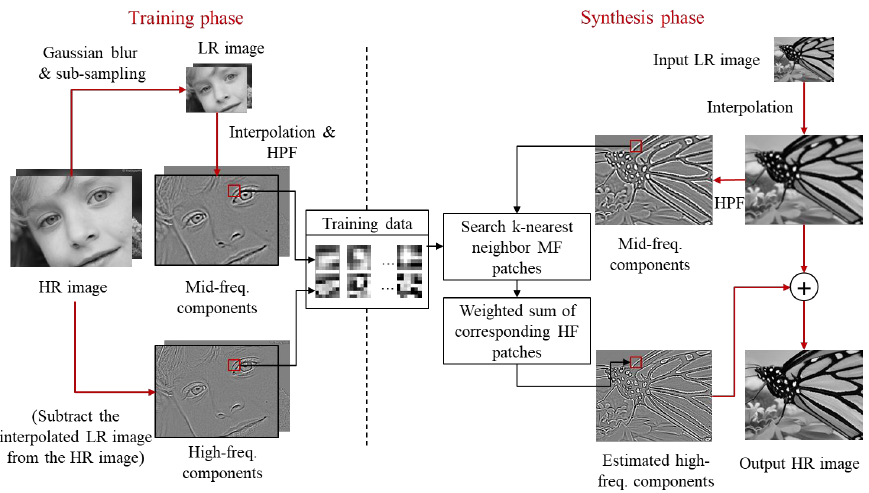
Figure 10. Example-based super-resolution using structure analysis of patches [7].